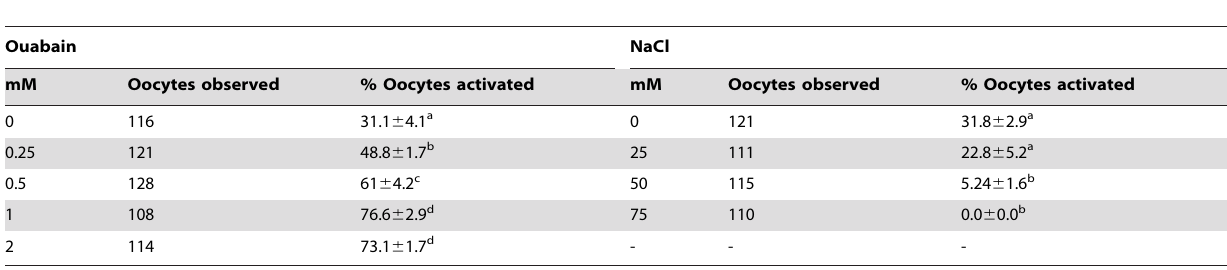
a–d: Values with a common letter in their superscripts do not differ (P . 0.05) in the same column. Ouabain was used in place of bepridil because many mouse oocytes lysed when treated with bepridil following ethanol activation